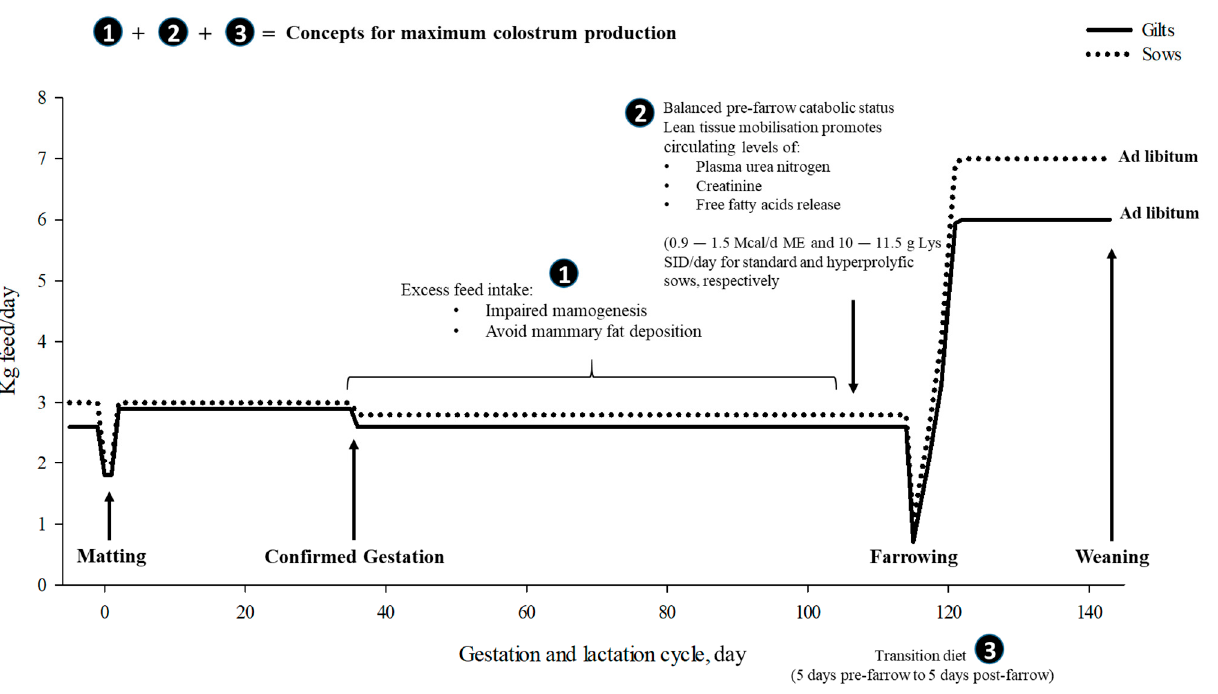
Figure 2. Nutritional strategies and feeding management concepts for maximum colostrum production in gilts and sows [89,168,169].